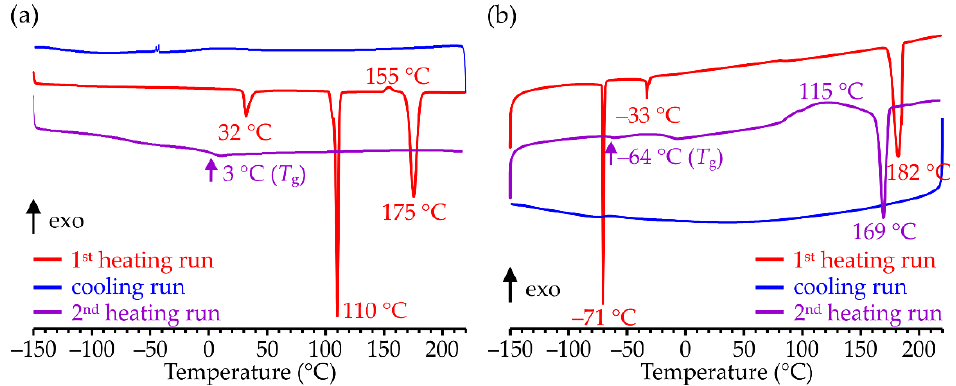
Figure 3. DSC traces of the pristine samples of: ( a ) ZnDMP, and ( b ) ZnDEP. The measurements were carried out in the following order of runs: 1st heating (red lines), cooling (blue lines, 2nd heating (purple lines). The glass transition temperatures are marked with arrows.